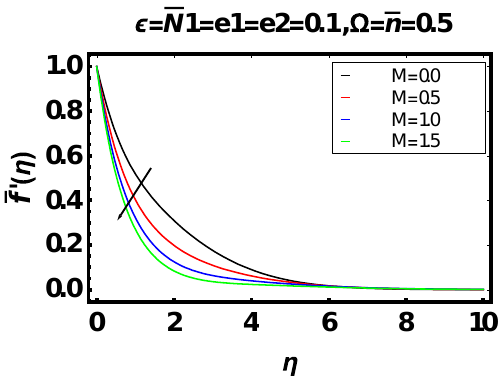
Figure 8. Velocity along x -direction for variant M .